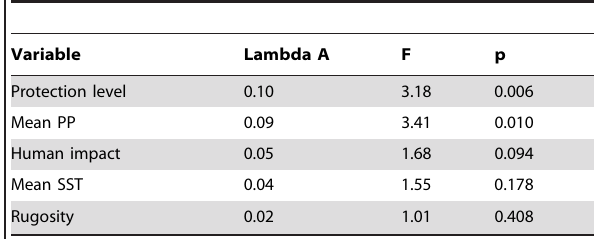
Table 3. Conditional effects of the Monte-Carlo permutation results on the redundancy analysis